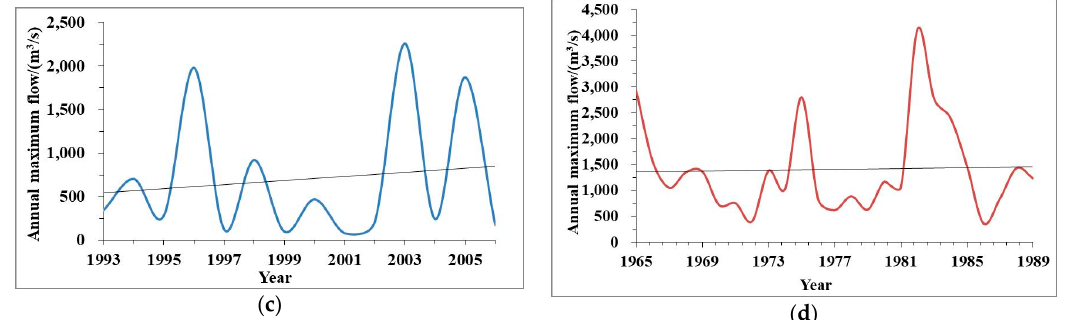
Figure 4. Sequence diagram of annual maximum flow. ( a ) According to the construction time of the project; ( b – d ) according to the theoretical variation point.